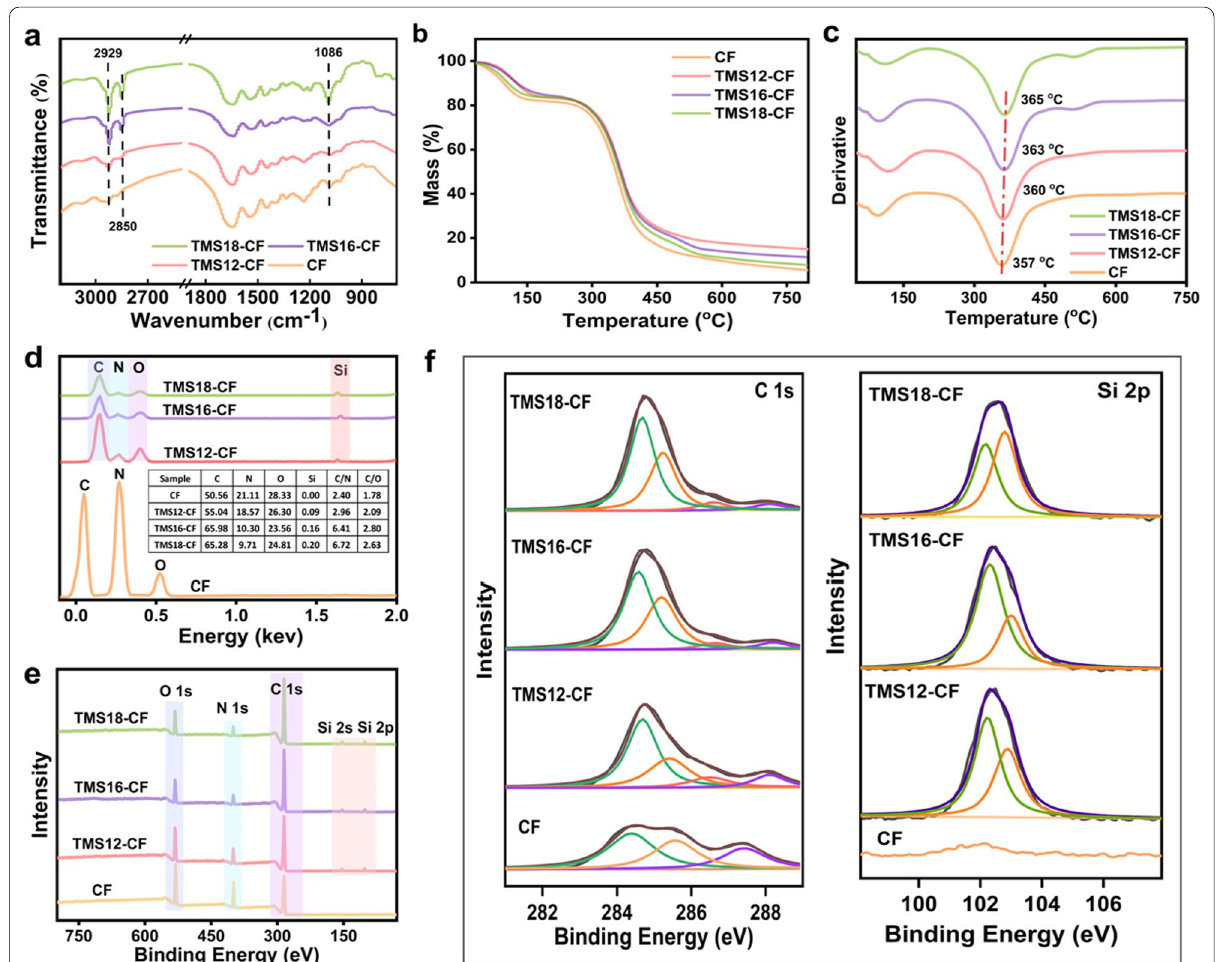
Fig. 2 Fourier transform infrared spectra ( a ), TGA curves ( b ), DTG curves ( c ), EDX spectra ( d ), XPS spectra ( e ), XPS C 1 s and Si 2p spectra ( f ) of CF, TMS12-CF, TMS16-CF and